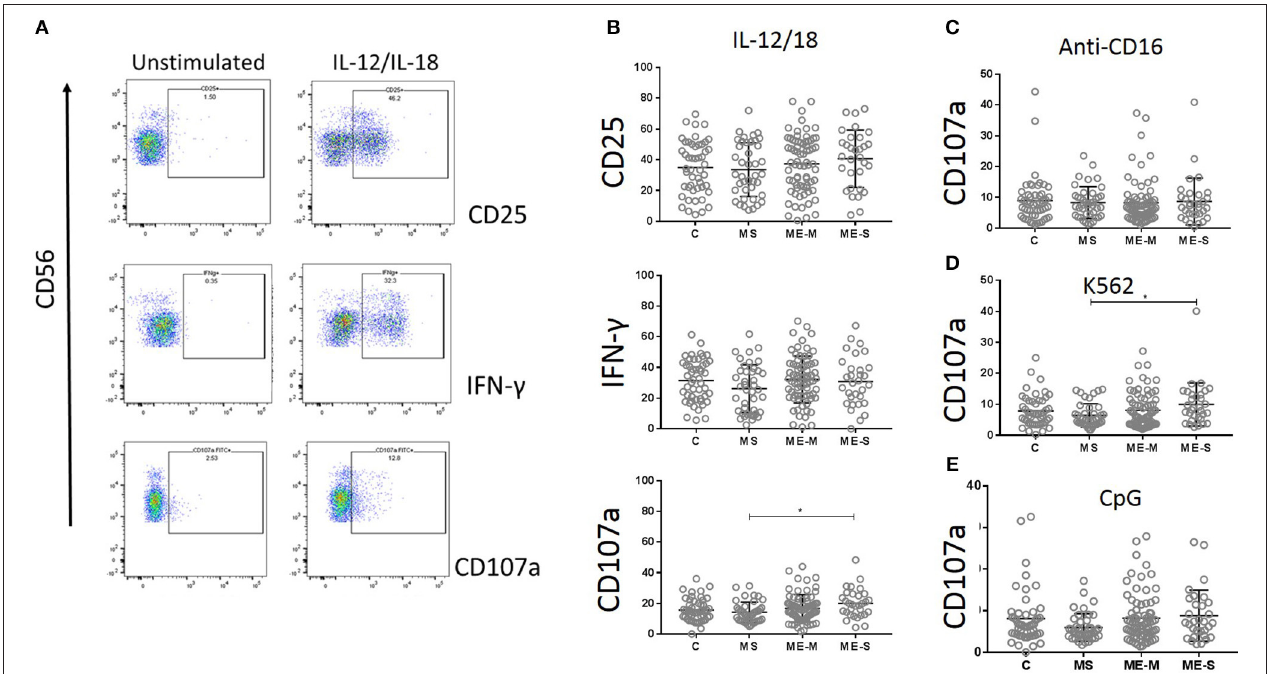
FIGURE 9 | Natural Killer Cell function in vitro in people with ME/CFS, people with MS and healthy controls. PBMC were incubated in vitro various stimuli and NK cell function analysed by flow cytometry. (A) Flow cytometry gating strategy showing NK cell (CD3 − CD56 + ) expression of CD25, IFN γ or CD107a (degranulation marker) following incubation with or without IL12/IL18 for 18h, in one representative donor. (B) Expression of CD25, IFN γ , and CD107 in NK cells following IL12/IL18 stimulation of PBMC from mild/moderately affected ME/CFS (ME-M: n = 76), severely affected ME/CFS (ME-S: n = 32) or multiple sclerosis (MS: n = 41) patients or healthy control (C: n = 50) individuals. CD107a expression on NK cells following 18h stimulation by (C) cross-linking anti-CD16 monoclonal antibodies, (D) MHC Class-I deficient K562 cells or (E) CpG. Within the dot plots, the lines show the means and the error bars show ±